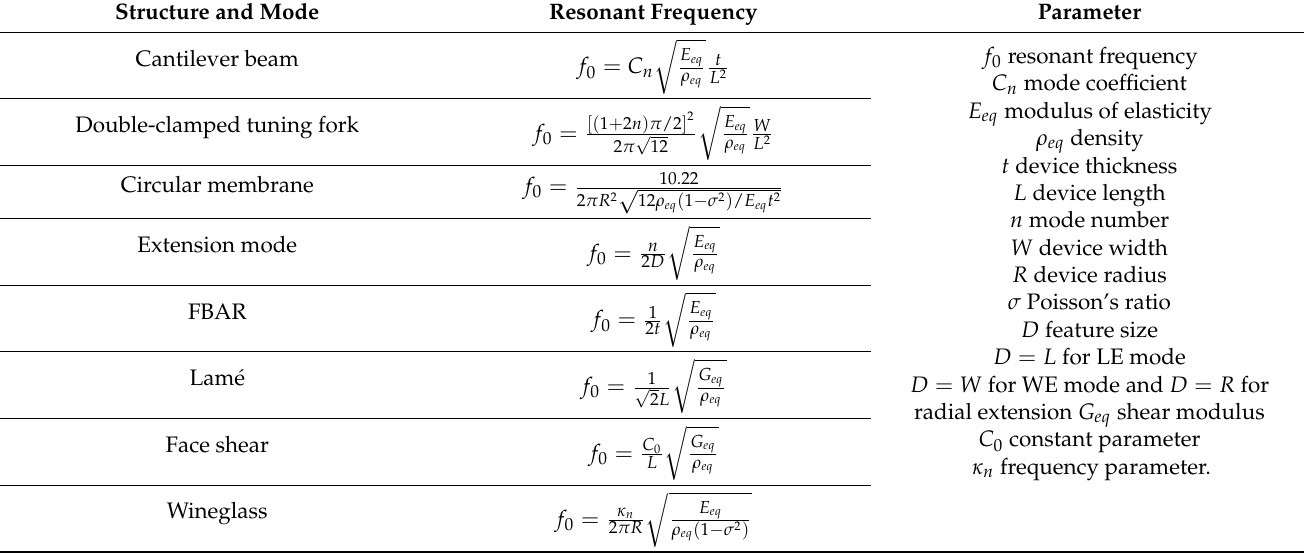
Table 1. Summary of frequency calculation formulas for common vibration modes.